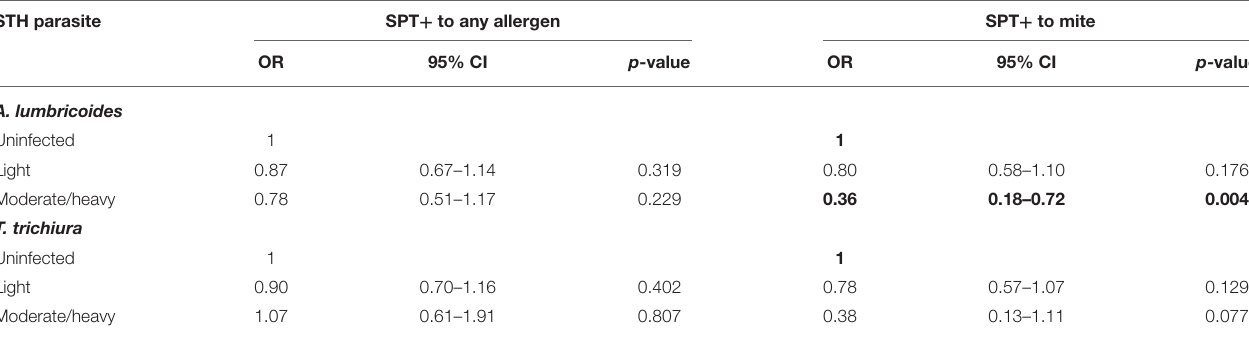
TABLE 3 | Multivariable associations between risk of allergen skin prick test positivity (SPT + ) to any and to mite allergens during first 8 years of life and infection intensities with A. lumbricoides and T. trichiura . STH parasite SPT + to any allergen SPT + to mite OR 95% CI p -value OR 95% CI p